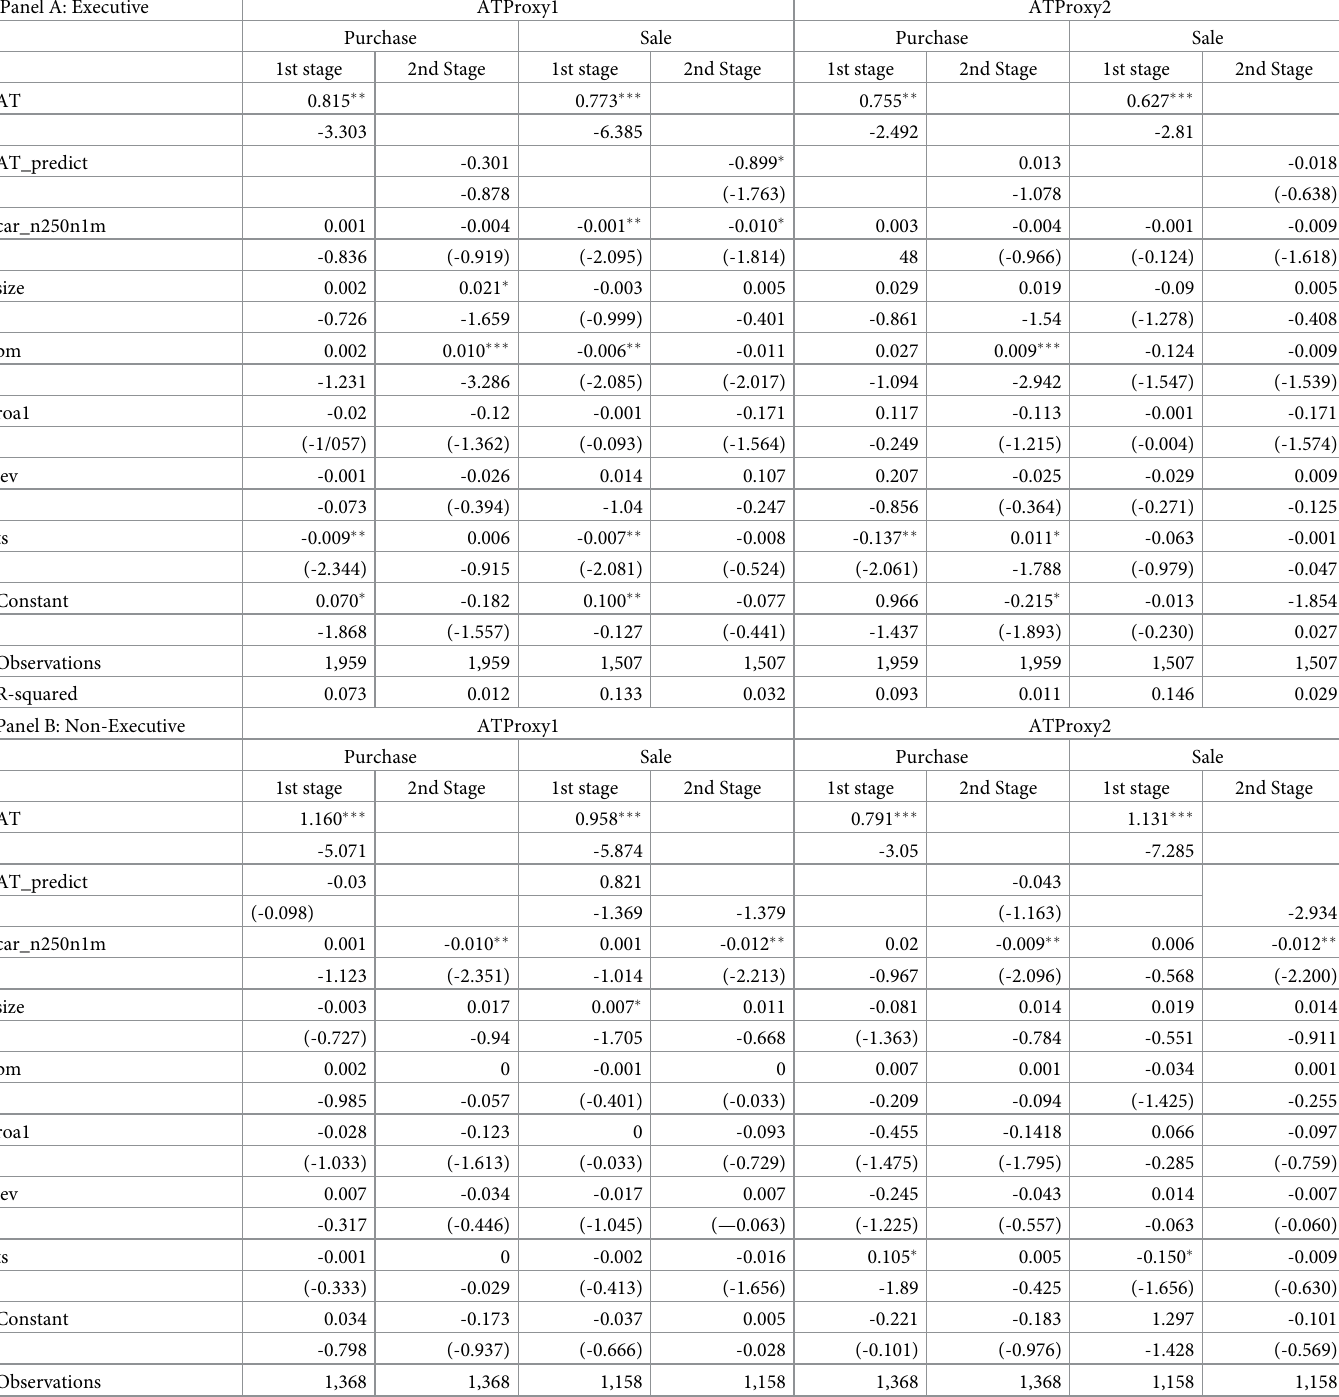
Table 5. AT and insider’s management level– 2SLS instrumental variable approach. Panel A: